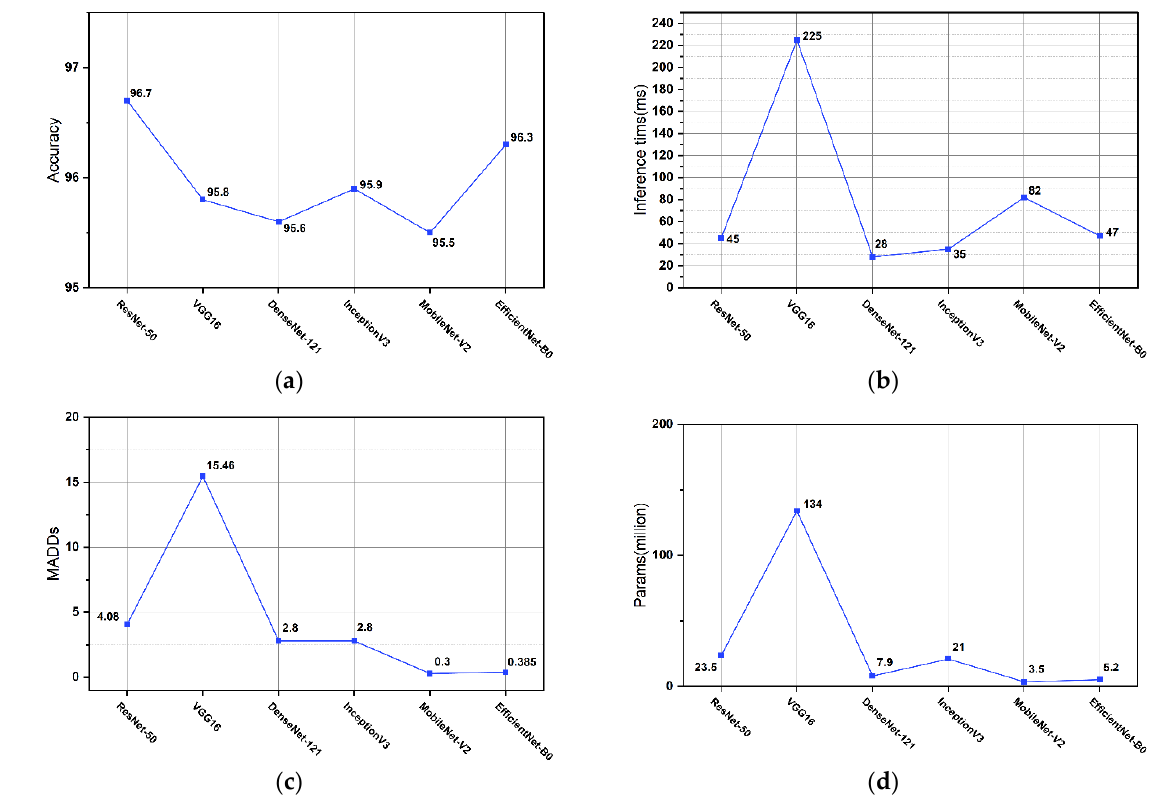
Figure 6. Accuracy, inference time, MADDs, and parameters for each CNN model after applying the proposed methodology. ( a ) Accuracy of each CNN model with the proposed methodology. ( b ) Inference time of each CNN model with the proposed methodology. ( c ) MADDs of each CNN model with the proposed methodology. ( d ) Parameters of each CNN model with the pro- posed methodology.